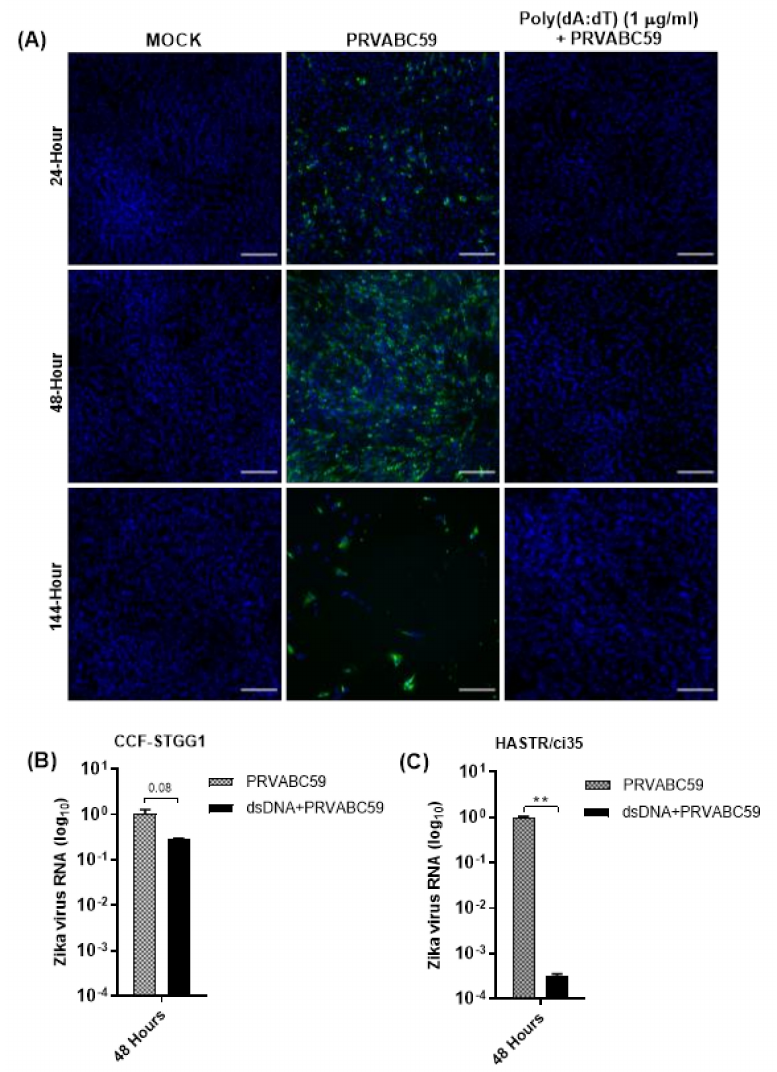
Figure 7. ( A ) Pre-stimulation of HASTR/ci35 astrocyte cells with higher concentration (1 µ g/mL) of poly(dA:dT) completely controlled PRVABC59 infection, unlike lower (0.3 µ g/mL) concentration of poly(dA:dT) pre-stimulation which did not show complete control (Figure 6). ( B , C ) Zika virus RNA load in poly(dA:dT) pre-stimulated CCF-STTG1 and HASTR/ci35 cells. Subconfluent ZIKV- susceptible HASTR/ci35 astrocyte cells were transfected with 1 µ g/mL of poly(I:C) or poly(dA:dT) 18 h prior to infection with PRVABC59 ZIKV strain at an MOI of 0.1. ( A ) Cells were fixed at 24-, 48- and 144-h timepoints and then stained with 4G2 antibody to detect ZIKV envelope protein Env (stained green) and DAPI stain for cell nuclei (stained blue). Scale bars represent 200 µ m. ( B , C ) Cell lysates were collected for relative quantification of viral RNA load at 48-h timepoint. Data were normalised to the 36b housekeeping gene and viral fold change at 48-h timepoint is expressed as a fold change relative to ZIKV RNA load at 6 hr timepoints. Viral RNA reduction (fold change) in poly(dA:dT) pre-stimulated cells was calculated considering the average viral RNA fold change compared with Zika-infected cells at 48-h timepoint. Unpaired T-test was performed to identify significant differences between two experimental conditions. ** demonstrates significant differences between biological conditions by p <